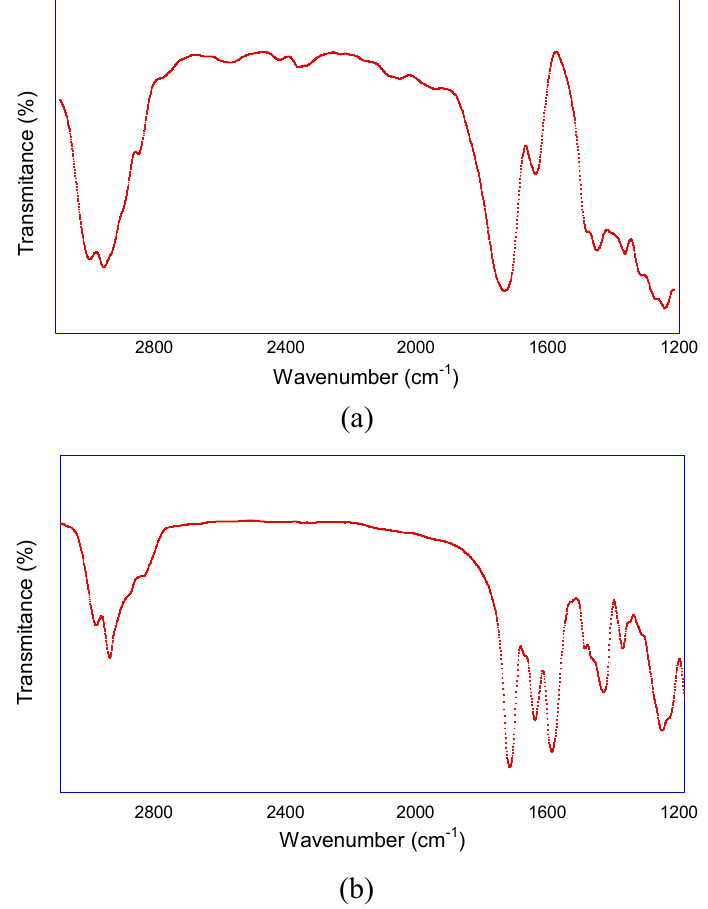
Figure 5. ( a ) FTIR spectrum of precursor 1a in the solid state. ( b ) FTIR spectrum of the isolated PMMA-NPs 2a synthesized by enamine “click”